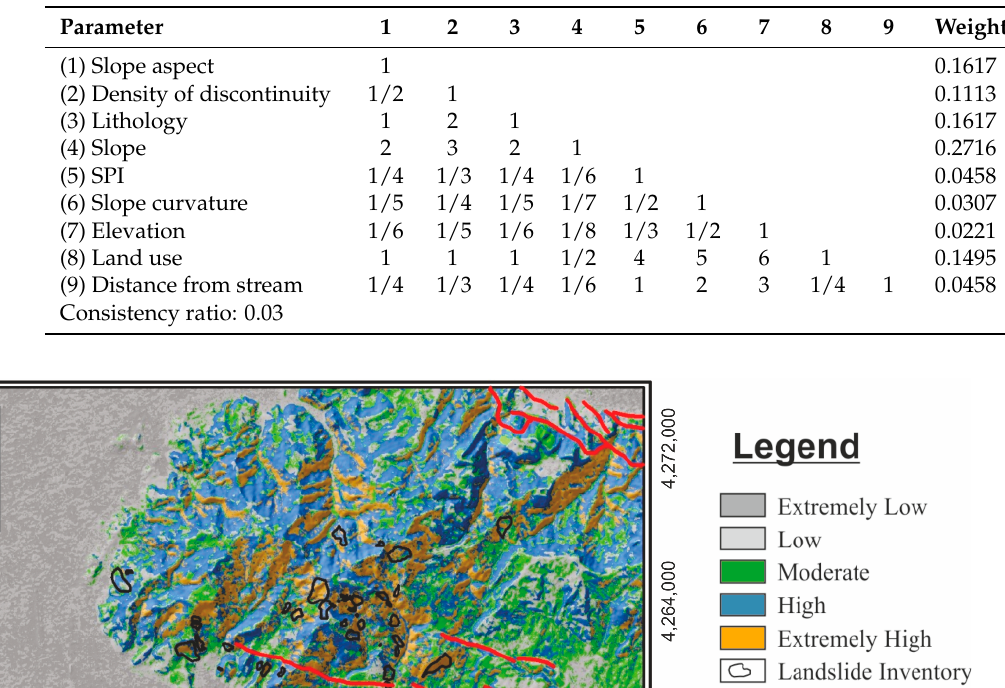
Table 4. Pair-wise comparison matrix, factor weights and consistency ratio of the data layers.